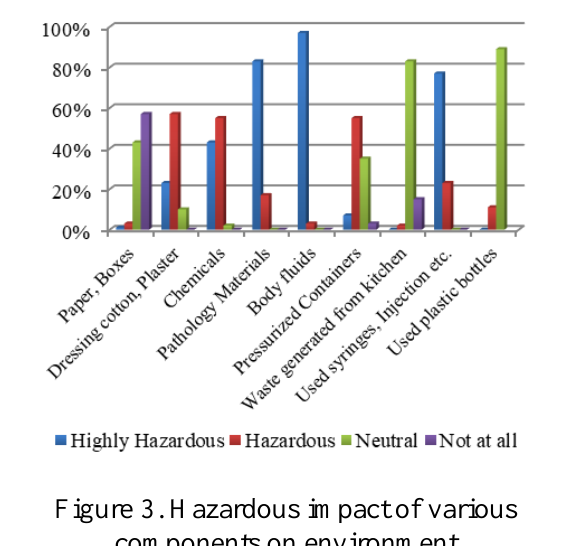
Figure 4. Frequency of workers putting the waste in the wrong